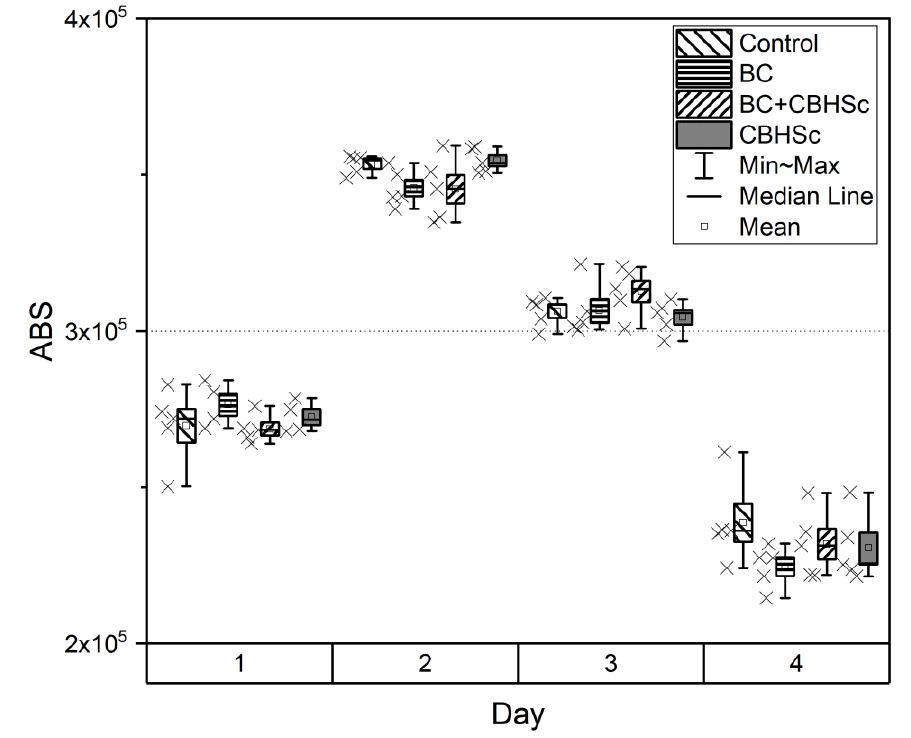
Figure 9. MTT-assay results on the cell proliferation for BC, CBHSc, and BC + CBHSc groups within four days.